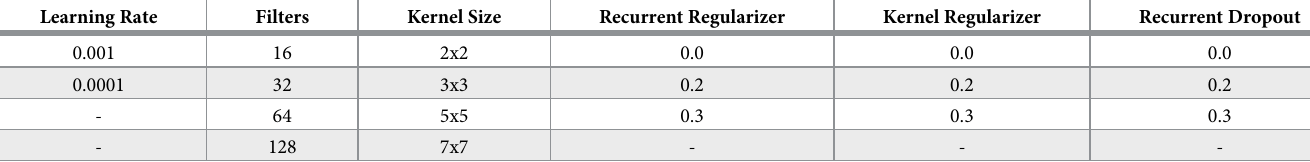
Table 1. Hyperparameter space for random search. Learning